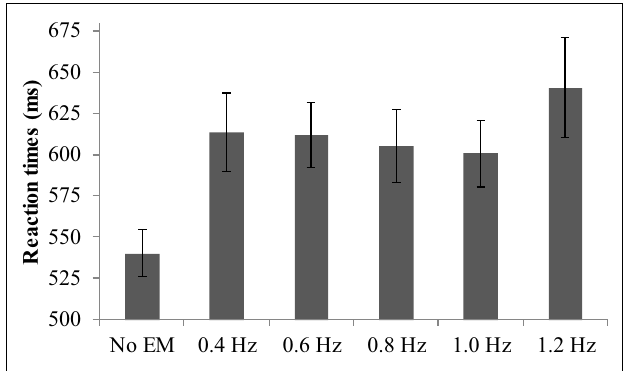
FIGURE 1 | Mean reaction times (ms) and SEs for the different speeds of EM and no EM